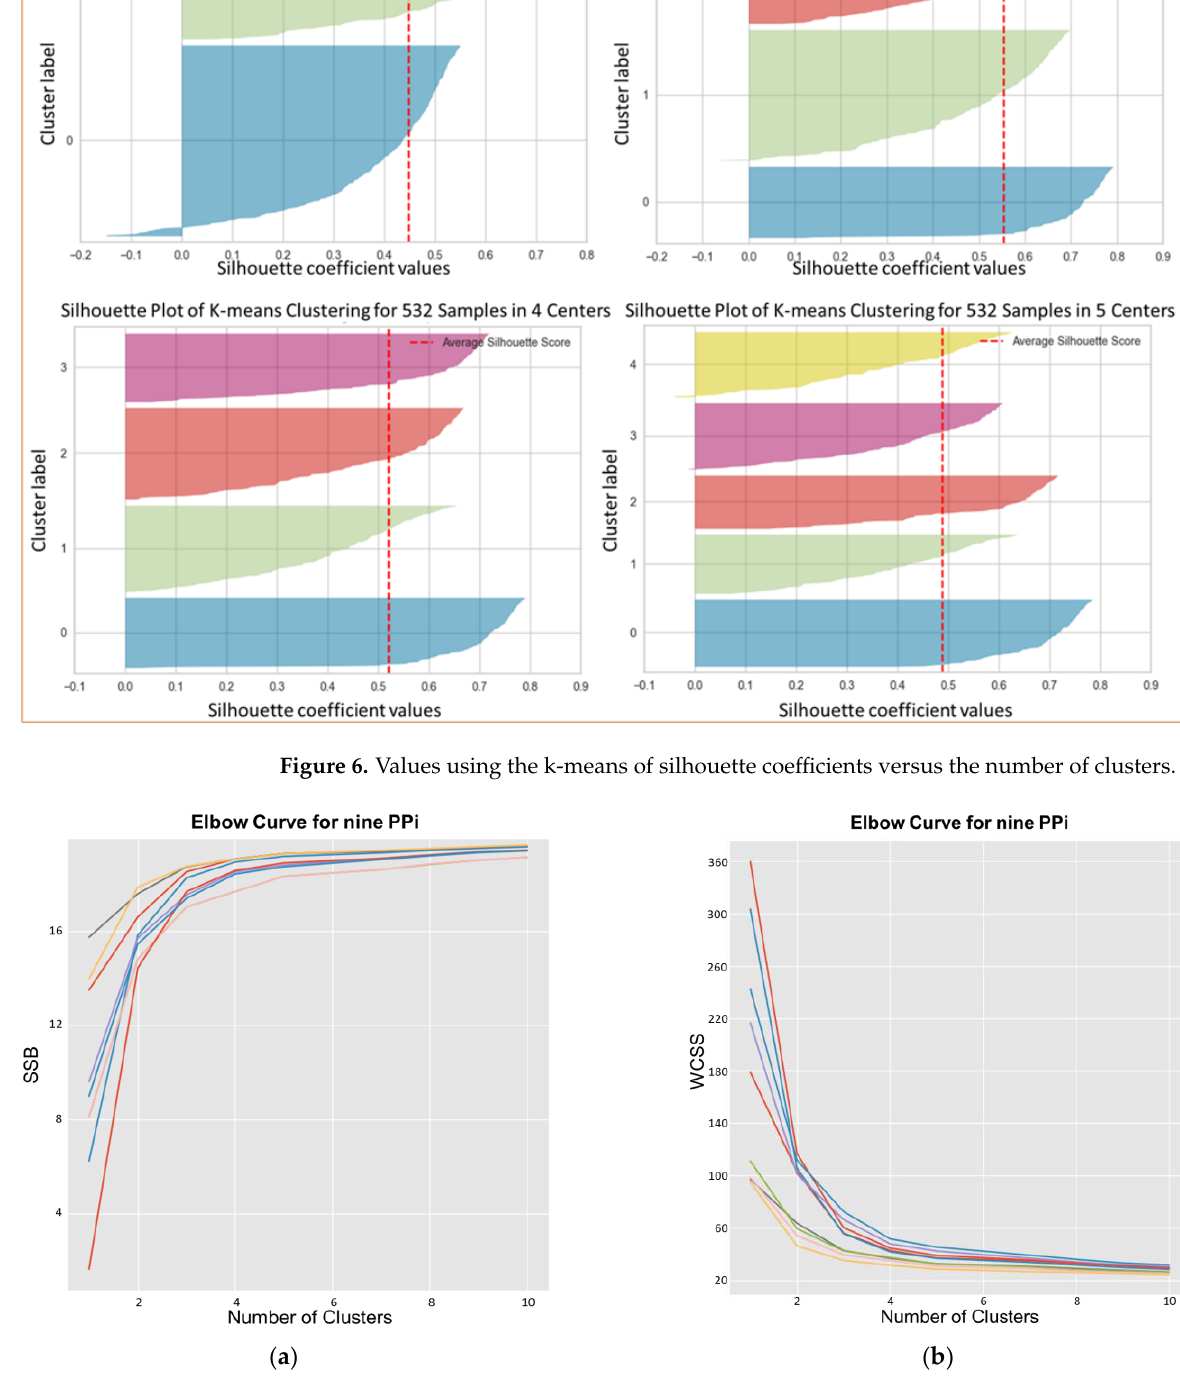
Figure 7. Values of score versus the number of clusters, using k-means for the elbow method. ( a ) Increasing elbow curves for the nine phenotyping pipeline (PPi) using SSB Equation (5). ( b ) Decreasing elbow curves for the nine PPi with respect to WCSS using Equation (4).